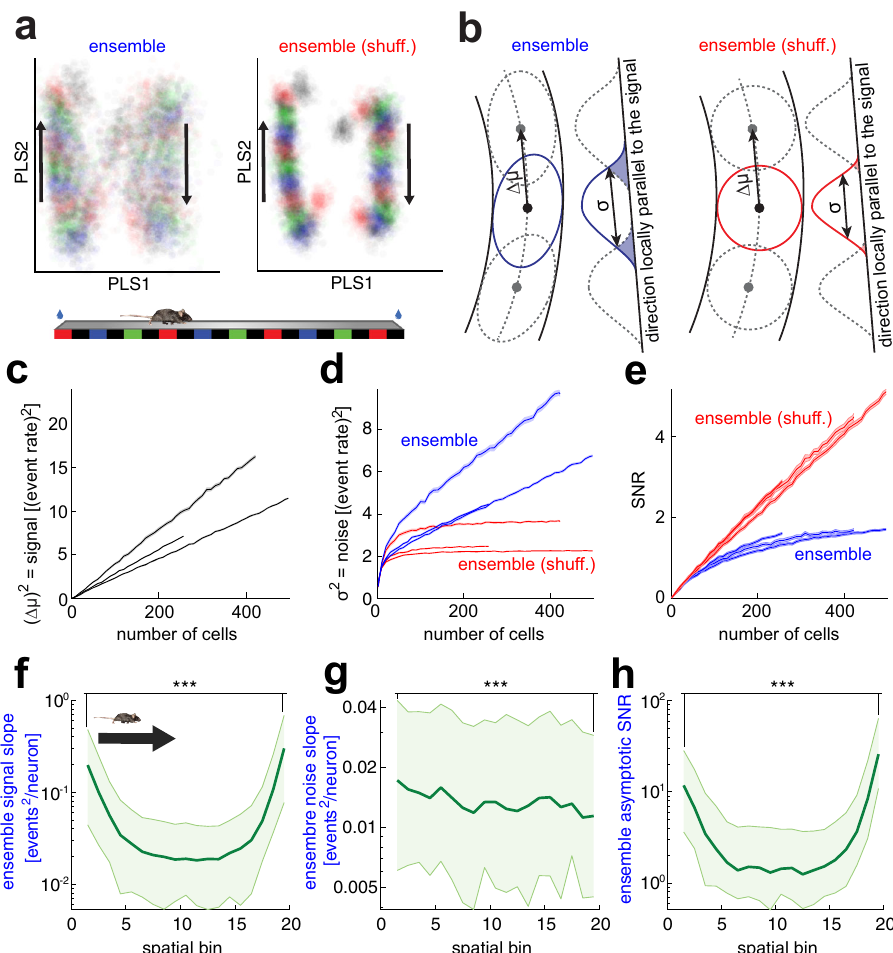
Fig. 3 Signal-to-noise ratio as a direct observable to measure the effect of noise correlations on the neuronal representation of the linear track. a Projection of the fi rst two dimensions identi fi ed by partial least squares (PLS) regression on position and direction of motion for each of the 40 bins from a single session with animal 2022. Same PLS components (from ensemble data) in both panels. Samples for each bin have different colors for visualization purposes. Each point on the plot represents the neuronal ensemble ’ s state within an individual trial and is color-coded according to the mouse ’ s spatial position (Bottom). The two leftmost clouds in each panel represent rightward runs, and the other two clouds leftward runs. b The schematic introduces Δμ as the distance vector between mean responses of adjacent spatial bins and σ as the neuronal activity standard deviation along Δμ . c Squared spatial signal, de fi ned as the median squared distance between mean neuronal responses of adjacent spatial bins. The shaded regions are the 95% con fi dence intervals over 80 random subsets of cells from a single session with example animal 2022 as in a . The shaded areas are small, and most points are under the line representing the mean value. The plot shows the same examples as in Fig. 2d, e. d Unmodi fi ed data (blue) noise variance along the spatial position encoding direction. The fl uctuations in the direction of spatial encoding are shared between neurons and cannot be eliminated by neuronal population activity averaging. Each plotted value is the median over spatial bins — shaded regions as in c . e SNR (signal in c divided by noise in d ) as a function of ensemble size. f Asymptotic signal slope for different spatial bins on rightward runs. Signal slope decreases signi fi cantly between the beginning and end of runs ( p = 2 × 10 − 18 , one-tailed Wilcoxon signed-rank test, n = 110 sessions). Shaded regions are the 95% con fi dence interval over trials from one session with example animal 2022 (same as a ). g Asymptotic noise slope displayed monotonic and signi fi cant decreases over the run ( p = 8 × 10 − 10 , one-tailed Wilcoxon sign rank test, pooling left and right runs, n = 110 sessions). Shaded regions as in f . h The asymptotic SNR (signal-slope / noise-slope) was signi fi cantly higher at the end of the run than at its initiation ( p = 2 × 10 − 29 , one-tailed Wilcoxon sign rank test, n = 110 sessions). Shaded regions as in f . Source data is provided as a Source Data fi